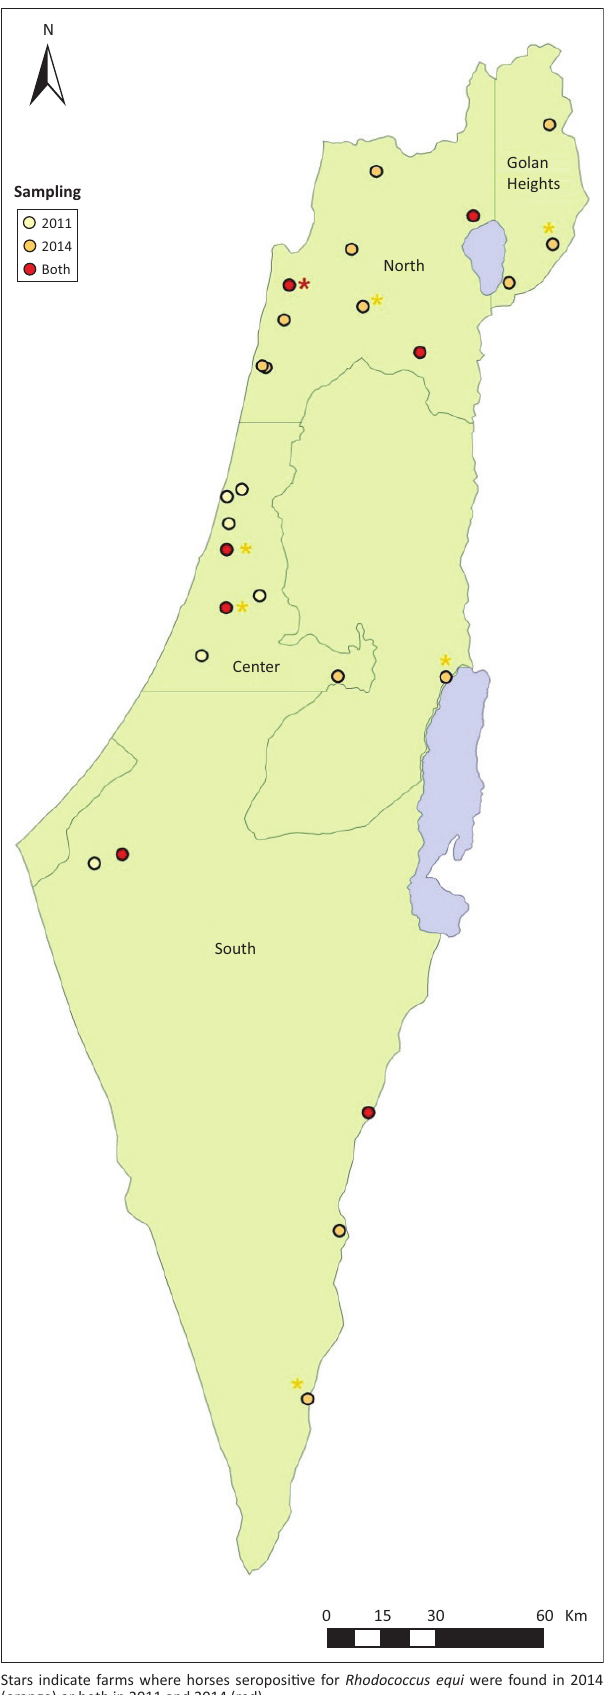
FIGURE 1: Geographic distribution of the farms sampled during 2011 (yellow), 2014 (orange) or both